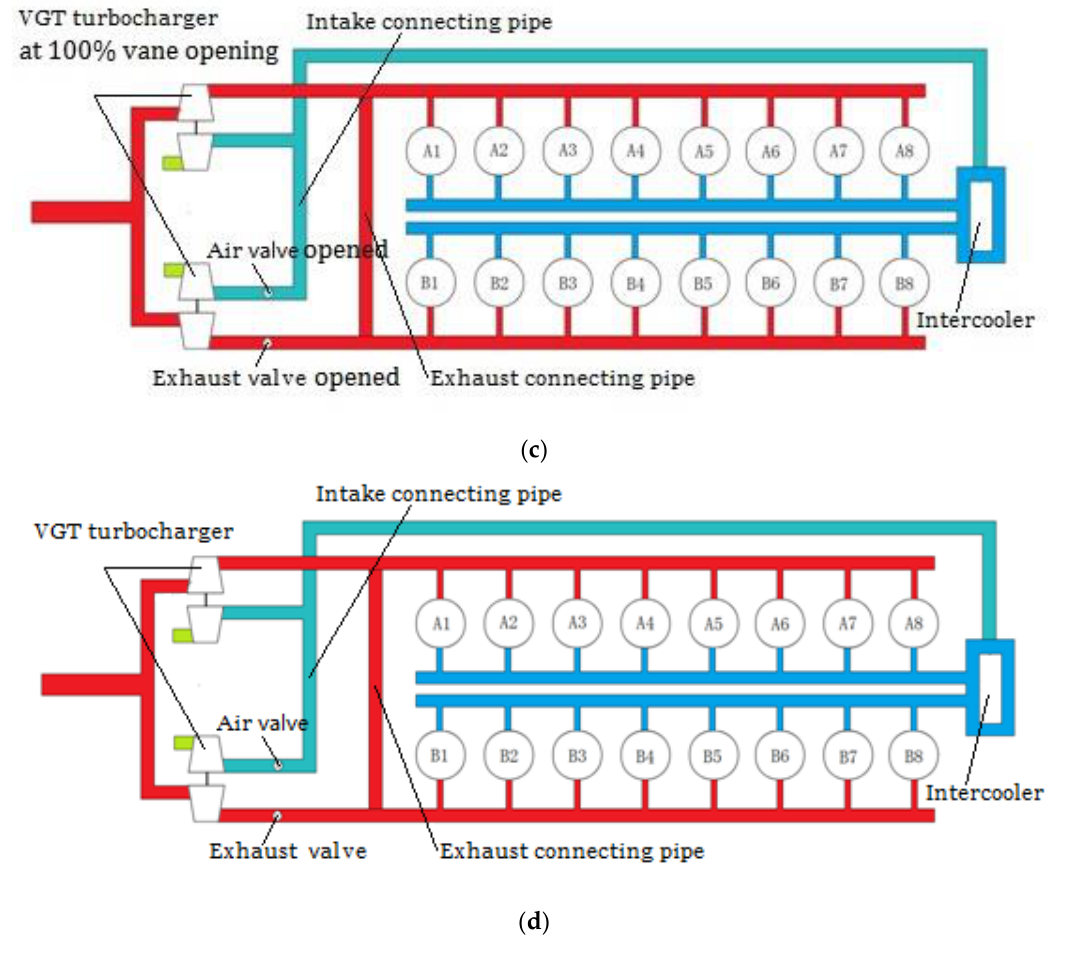
Figure 1. Schematic of the VGT, STC-1TC, STC-2TC, and the compound VGT-STC systems. ( a ) VGT; ( b ) STC-1TC; ( c ) STC-2TC; ( d ) Compound VGT-STC. Table 2. The control strategy of the VGT-STC system.